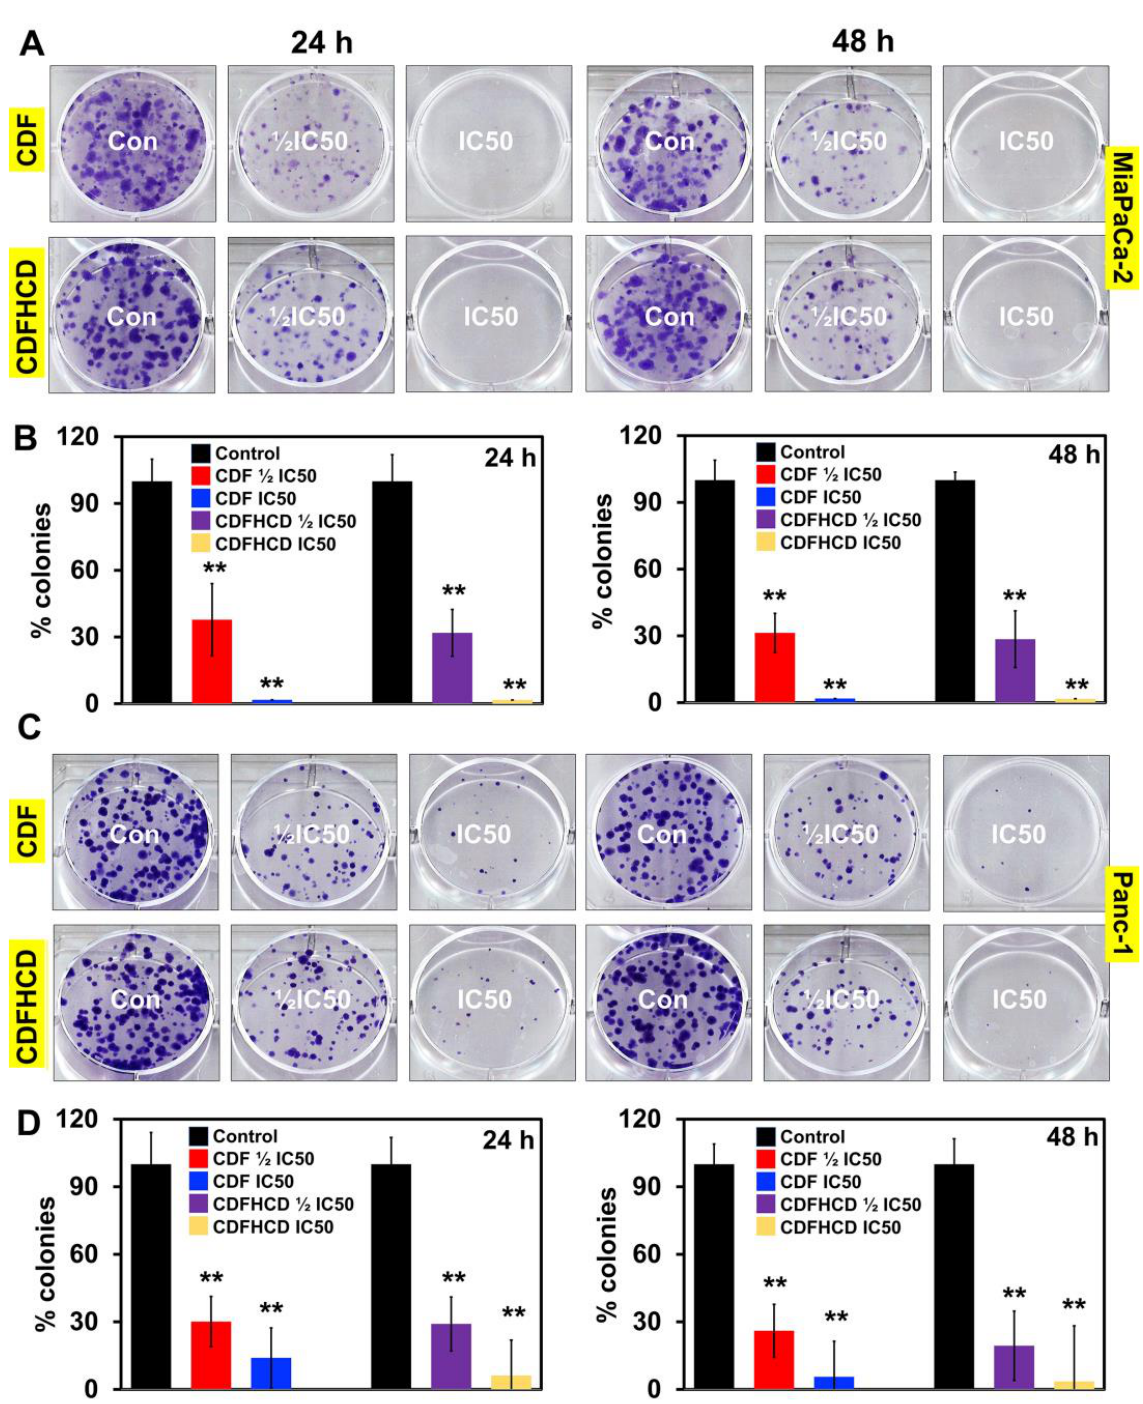
Figure 3. CDF and CDFHCD inhibit the proliferation of PDAC cell lines. ( A ). PDAC cells (MiaPaCa- 2, Panc-1, Panc01728, and S2-007) were treated with increasing concentrations of CDF and CDFHCD (0 –5 μM) for up to 72 h and studied using hexosaminid ase assay. ( B ). The IC 50 values of the antipro- liferative activity are summarized in the tabular format as mean ± SD.